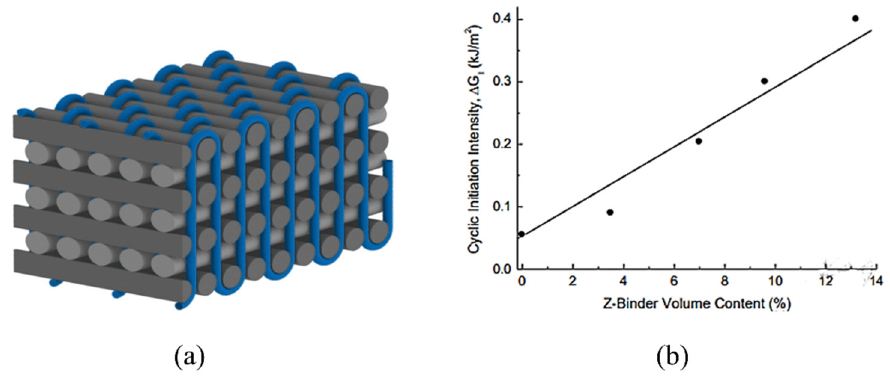
Figure 9. 3D Woven reinforcement ( a ) and influence of z-binder yarn volume on the cyclic stress intensity factor ( b ) [50].